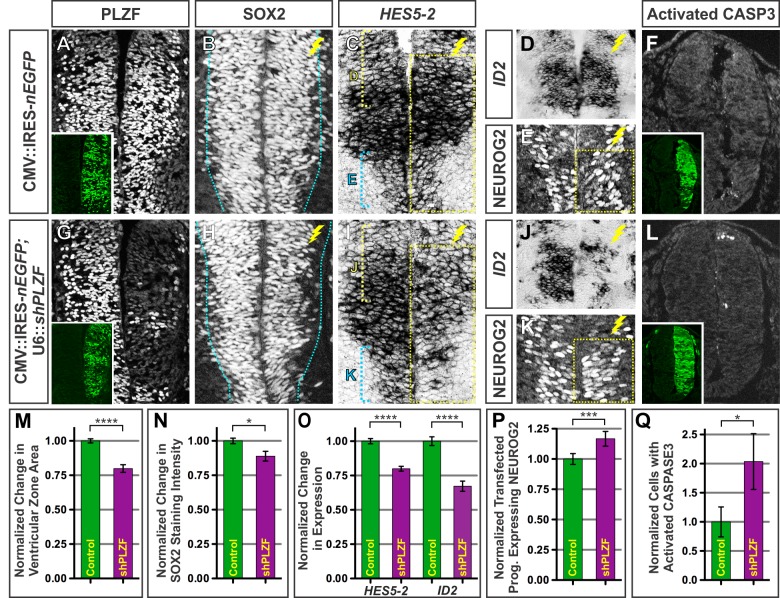
Reduced PLZF activity compromises progenitor maintenance and promotes neuronal differentiation.(A, G) Electroporation of chick embryos with shRNA vectors against PLZF (U6::shPLZF) at e2 (HH 10) dramatically reduces the expression of PLZF protein in the developing spinal cord upon collection at e4 (HH 21). Insets show the extent of electroporation marked by nEGFP fluorescence. (B, H, M) PLZF knockdown reduces the area of the VZ. Chart indicates the mean VZ area ± SEM for both control and shPLZF-electroporated embryos relative to the untransfected contralateral sides of the spinal cord. Blue dotted lines demarcate the border of the contralateral VZ in each image. (B–D, H–J) PLZF knockdown reduces the expression of multiple genes and proteins associated with progenitor maintenance including SOX2, HES5-2, and ID2. (E, K) PLZF loss coincides with an increase in the number and density of cells expressing the proneural transcription factor NEUROG2 within the VZ. (F, L, Q) PLZF knockdown also increases the frequency of apoptotic cell death. (N) Chart displays the mean pixel intensity of SOX2 staining ± SEM in shPLZF-transfected cells relative to empty vector controls. (O) Chart displays the level of HES5-2 and ID2 mRNA in control and shPLZF-electroporated spinal cords, relative to the contralateral control sides. (P–Q) Charts display the mean number of shPLZF-transfected cells ± SEM expressing the indicated markers relative to empty vector controls. Data are representative of at least 10 images taken from ≥8 embryos electroporated in the same experiment. In all panels, *p<0.05, **p<0.01, ***p<0.001, and ****p<0.0001.